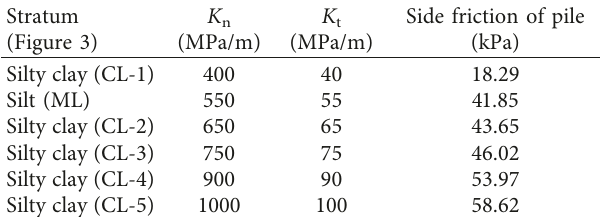
Table 4: Soil mechanical